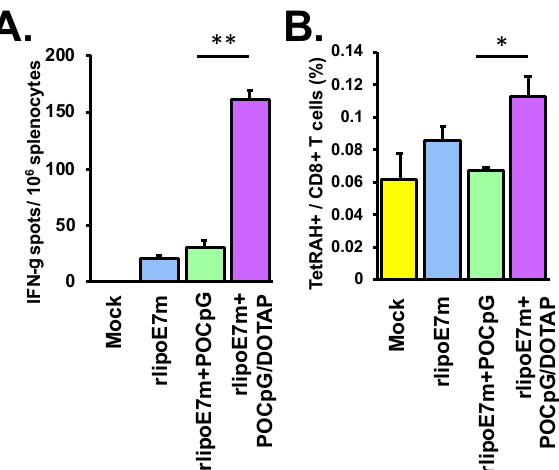
Figure 3. The combination of rlipoE7m and POCpG / DOTAP could elicit cytotoxic T lymphocyte (CTL) responses via tail vein injection. C57BL / 6 mice were immunized with rlipoE7m, rlipoE7m + POCpG, or rlipoE7m + POCpG / DOTAP combined on days 0 and 7 via the tail vein. Cells were collected from the spleens of mice that received tail vein injection. ( A ) IFN- γ -producing CTLs were determined by ELISPOT. ( B ) Antigen-specific CTL populations were detected by RAH tetramer and anti-CD8 antibody and then analyzed by flow cytometry. Cells were gated by CD8 + staining to determine the percentage of RAH tetramer + cells. These data were collected and analyzed from two independent experiments. (The rlipoE7m + POCpG / DOTAP group vs. rlipoE7m + POCpG group, * p < 0.05, ** p < 0.01. Each mouse group n = 6).